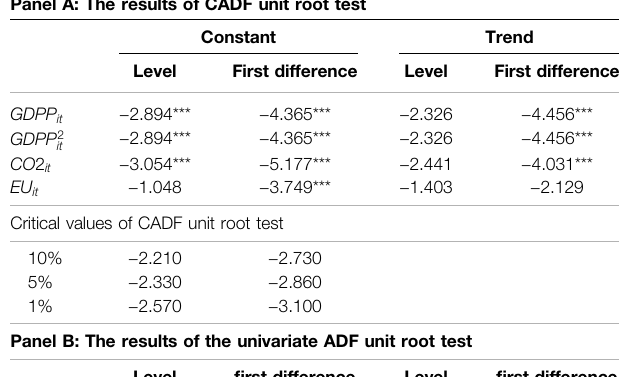
TABLE 3 | The results of CADF and ADF unit root tests. Panel A: The results of CADF unit root test